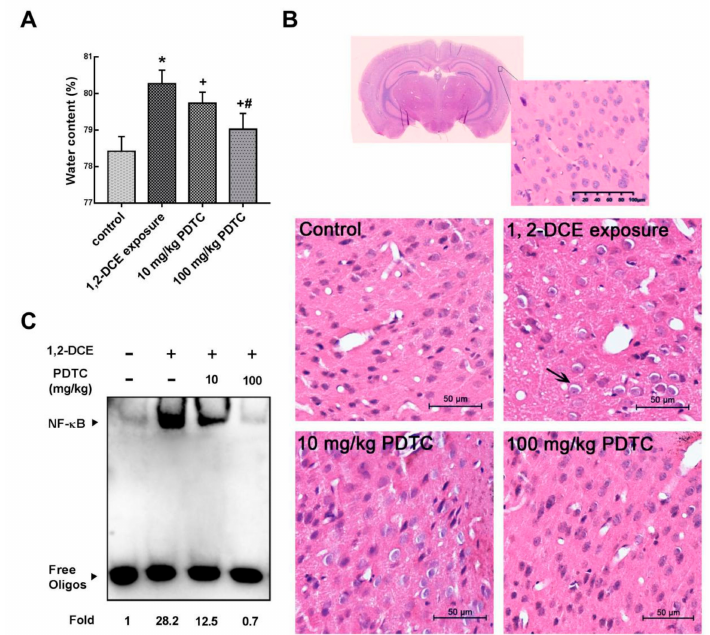
Figure 1. Involvement of NF- κ B in brain edema in 1,2-DCE-intoxicated mice. ( A ) Comparison of mouse brain water content among groups. ( B ) The photomicrographs of HE staining in the frontoparietal region of the cerebral cortex are representative of five separate experiments and were captured using a Nikon microscope (200 × ). The arrow indicates the enlarged perinuclear space. Scale bar represents 50 µ m. ( C ) The image of DNA binding activity of NF- κ B by electrophoretic mobility shift assay (EMSA) is representative of at least three experiments. Data expressed as mean ± SD are the results of five independent experiments and analyzed by one-way ANOVA. Significant di ff erence is defined as p < 0.05, and *, vs. control group; + , vs. 1,2-DCE poisoned group; # vs. low dose intervention